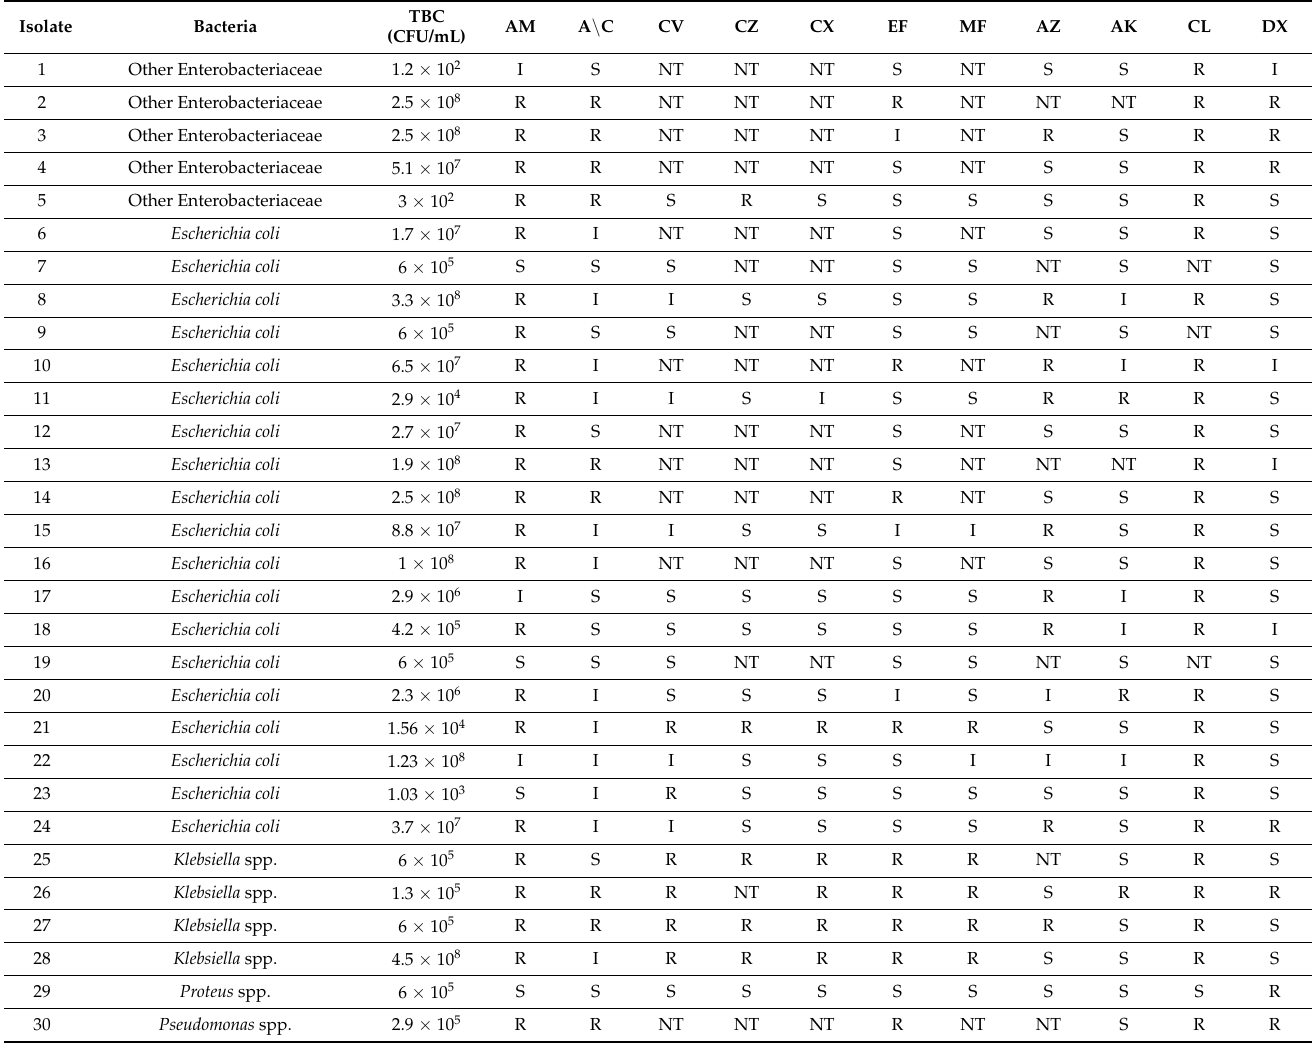
Table A1. Bacterial isolates, TBC, and antimicrobial sensitivity test